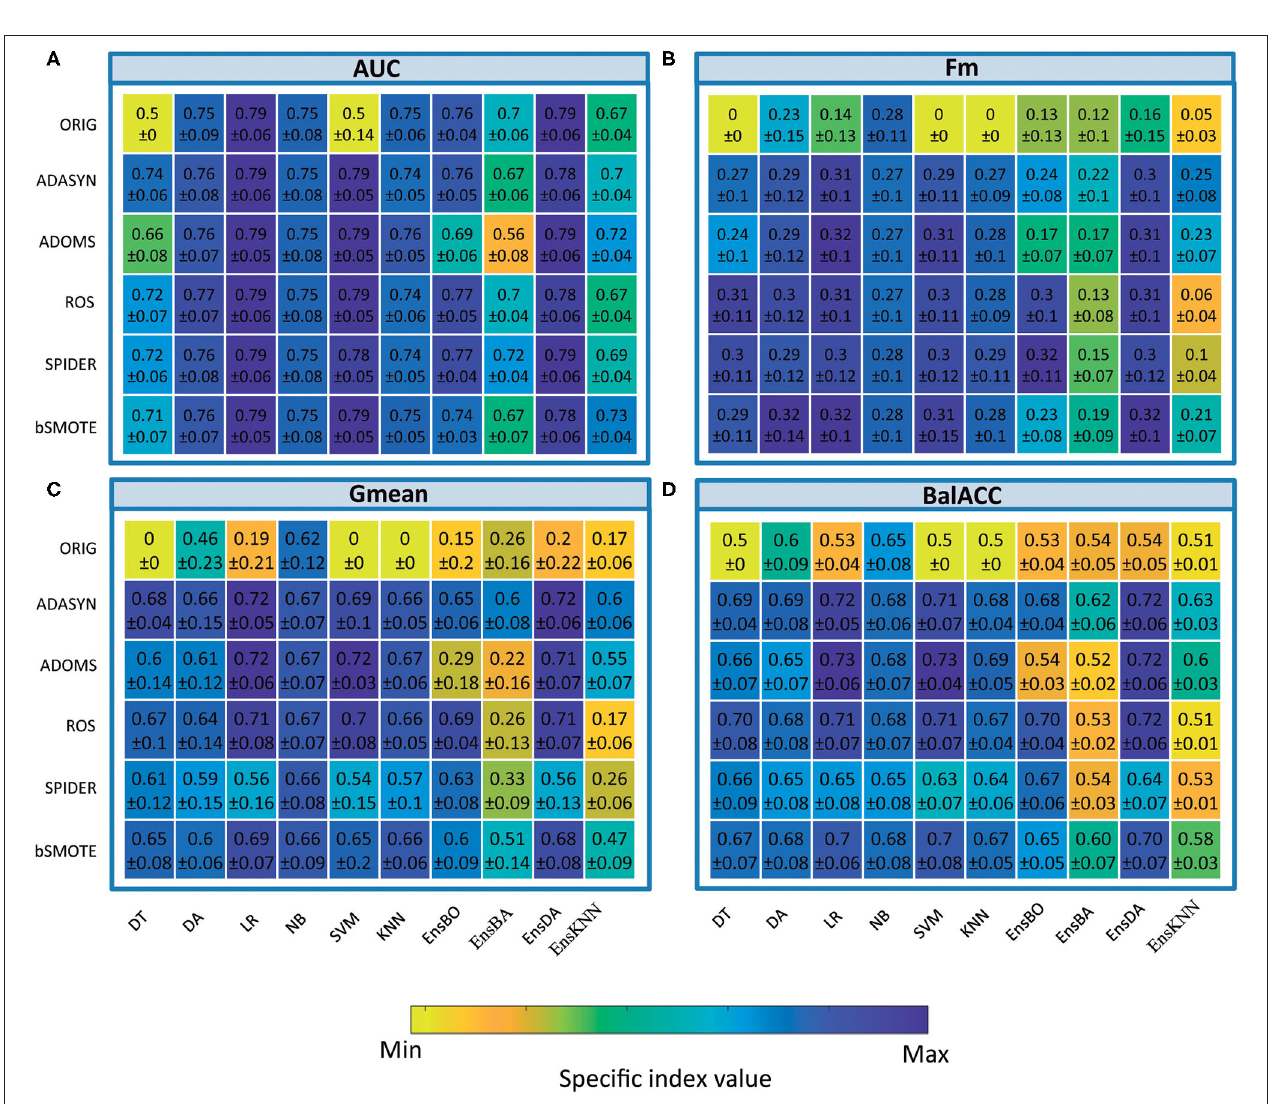
FIGURE 2 | Comparison of classifier performances (mean and SD values), among the different oversampling procedures, in terms of indices Area under the ROC curve (AUC) (A) , F-measure (Fm) (B) Geometric Mean (Gmean) (C) , and Balanced Accuracy (BalACC) (D) . X -axis: classifiers applied; Y -axis: resampling techniques. For ease of understanding, the colormap spans from minimum to maximum values of each specific index. As shown in Table 2 and Supplementary Tables 2 – 5 for statistical comparisons among these